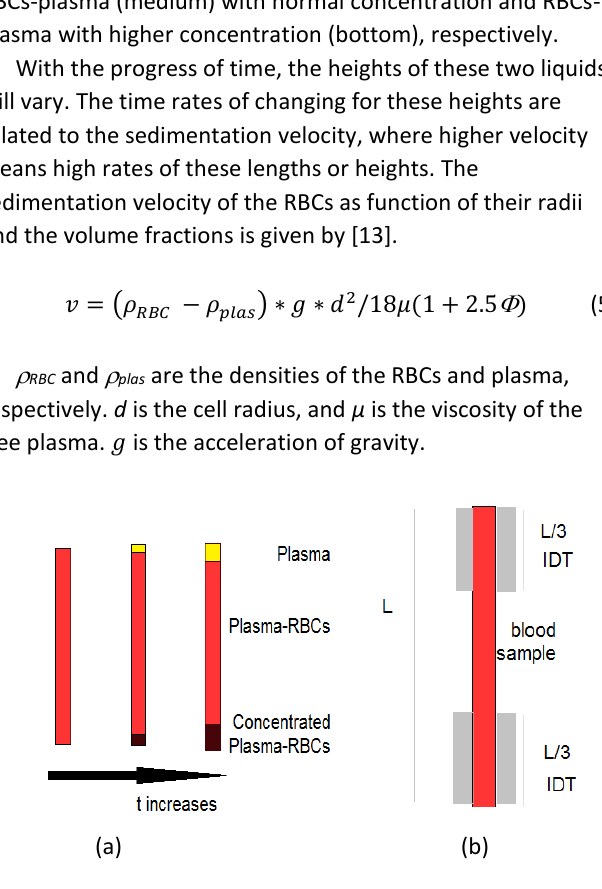
Fig.1 a): The sedimentation process and formation of three different solutions. b) SAW with blood